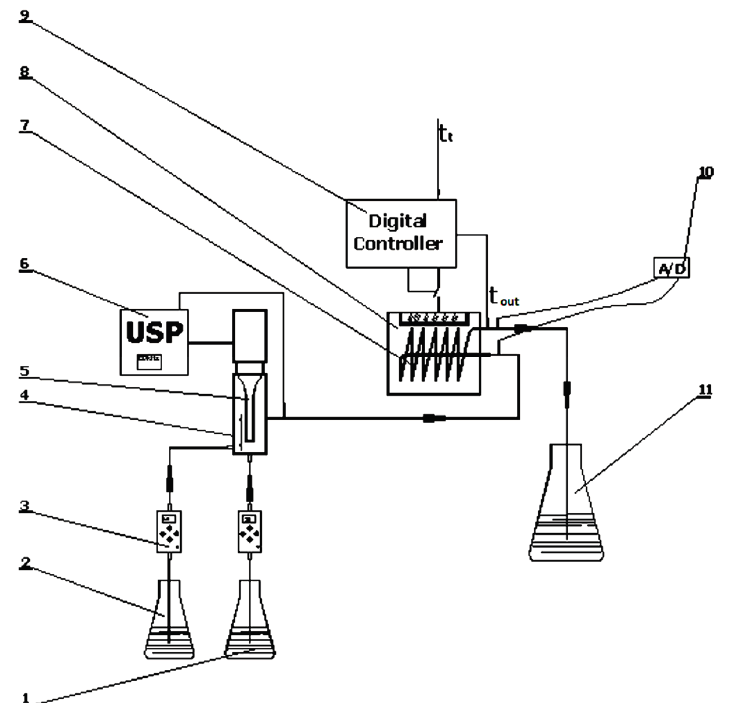
Figure 1. Scheme of a continuous flow laboratory set-up for CuO preparation. 1,2-storage tanks; 3-metering pump; 4-continuous flow cell; 5-ultrasonic mixer; 6-ultrasonic generator; 7-tubular 11-product